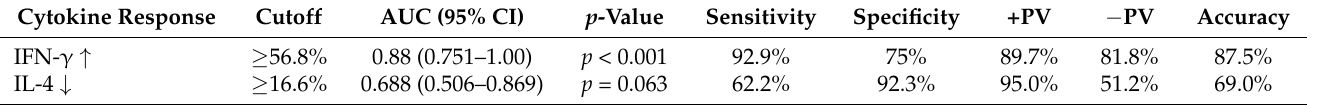
Table 2. Validity of the in vitro cytokine response to predict the therapeutic response the bivalent HPV vaccine. Cytokine Response Cutoff